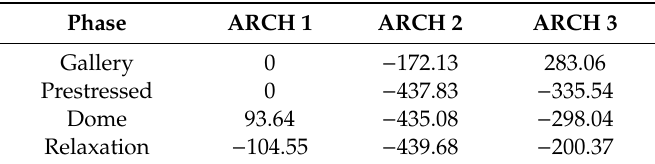
Table 19. Axial forces in kN on arches.